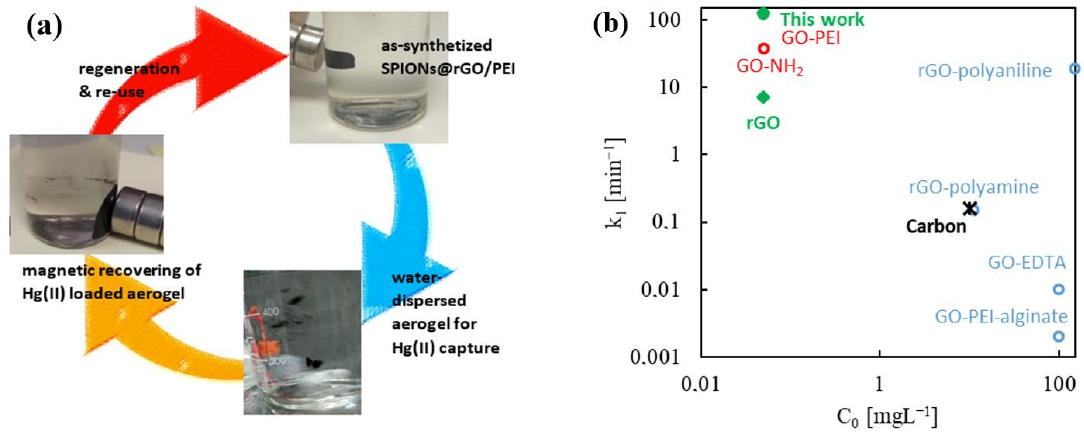
Figure 6. The behavior of the SPIONs@rGO/PEI aerogel synthetized for Hg(II) capture: ( a ) water behavior of the magnetic aerogel showing that an external magnet can be used to recover the loaded sorbent for re-use, and ( b ) the sorption of Hg(II) in a multicomponent solution onto rGO/PEI, either net or with deposited SPIONs, over time.